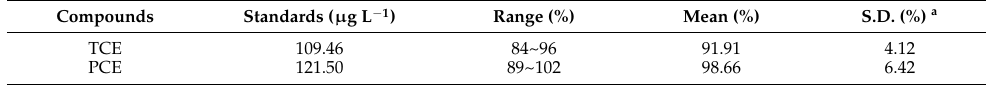
Table 3. Recoveries (%) of TCE and PCE (n = 6).